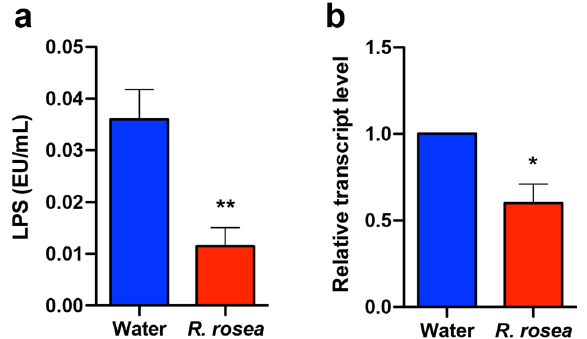
Figure 7. Rhodiola rosea treatment reduces circulating LPS and hepatocyte CRP expression. At 14 weeks of age, mice were sacrificed and serum and liver tissue obtained. ( a ) Serum LPS levels, measured by the LAL assay (n = 8 for water-treated and n = 6 for R. rosea -treated mice). ** P < 0.01, Mann–Whitney U test. ( b ) Relative expression of CRP transcripts in mouse liver, calculated by the ΔΔCt method (n = 6 for water-treated and n = 5 for R. rosea -treated mice). *P < 0.05 , one sample Wilcoxon